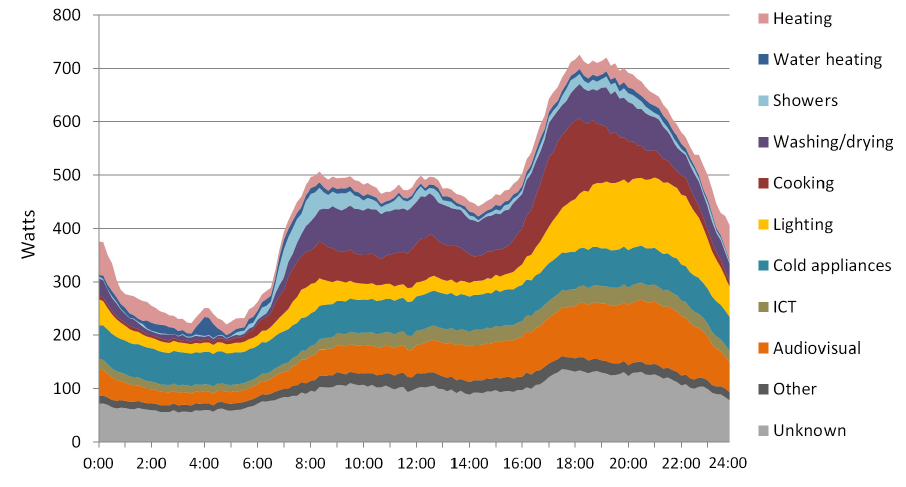
Figure 2. Illustration of the hourly energy consumption of different appliances (per household) from survey data. The image corresponds to average energy consumption of all participating household for working